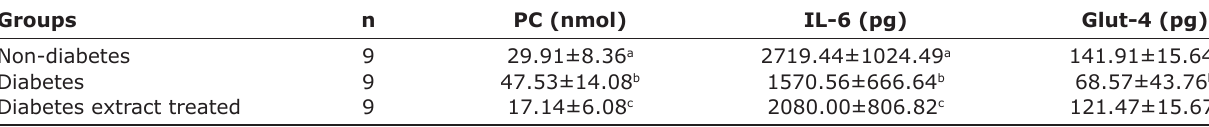
Table-2: Level of PC, IL-6, and Glut-4 in mg calf muscle tissue.